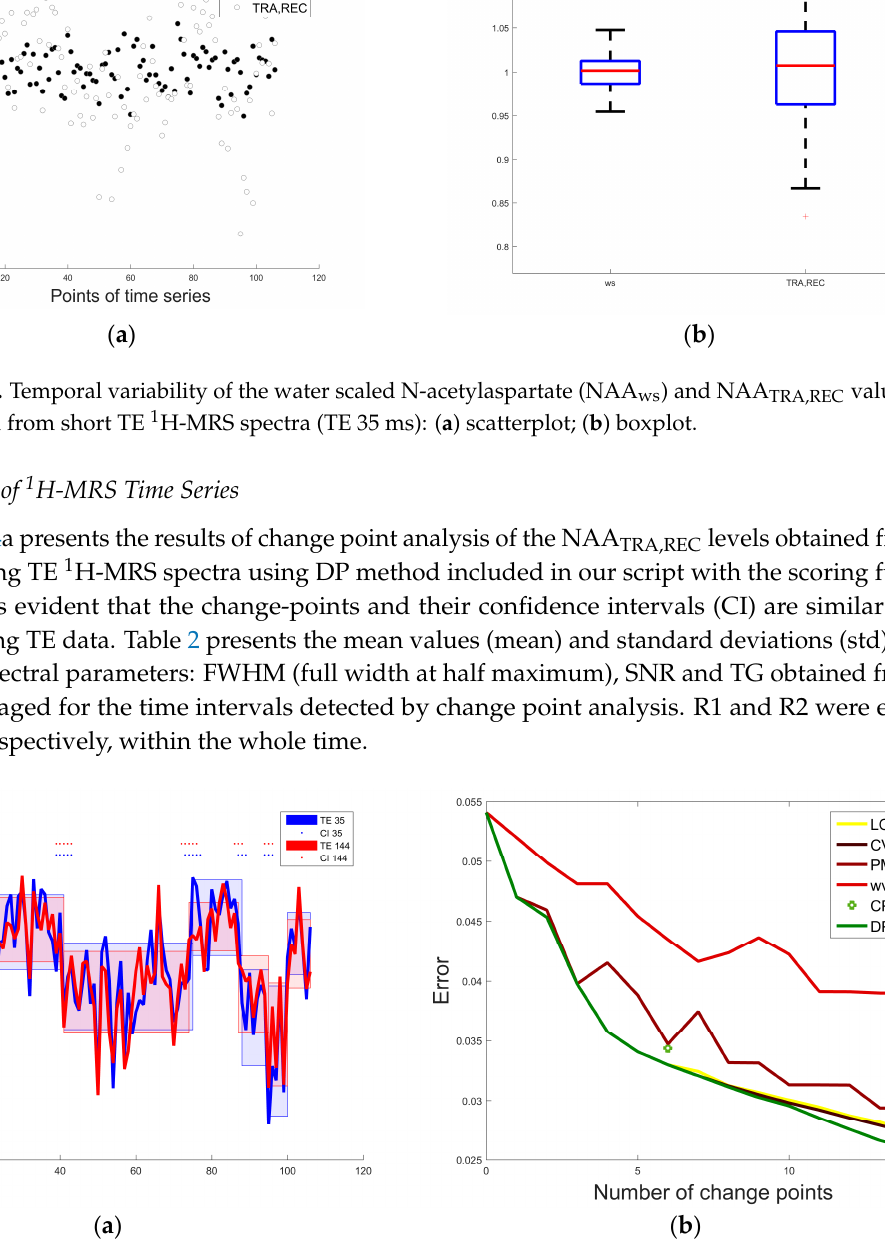
Figure 4. Time series analysis of the NAA TRA,REC levels obtained from the short (blue) and long (red) TE 1 H-MRS spectra: ( a ) visualization of the change points and corresponding confidence intervals (CI); ( b ) the relation between the error values (computed using Equation (4)) and the change points numbers obtained using various methods for short TE. Table 3. The error values (computed using Equation (4)) obtained from the NAA TRA,REC levels series analysis for a predefined number of six change points. The time points correspond to the following dates of the measurements: 13 — 19 October 2006, 41 — 30 October 2007, 75 — 19 December 2008, 88 —